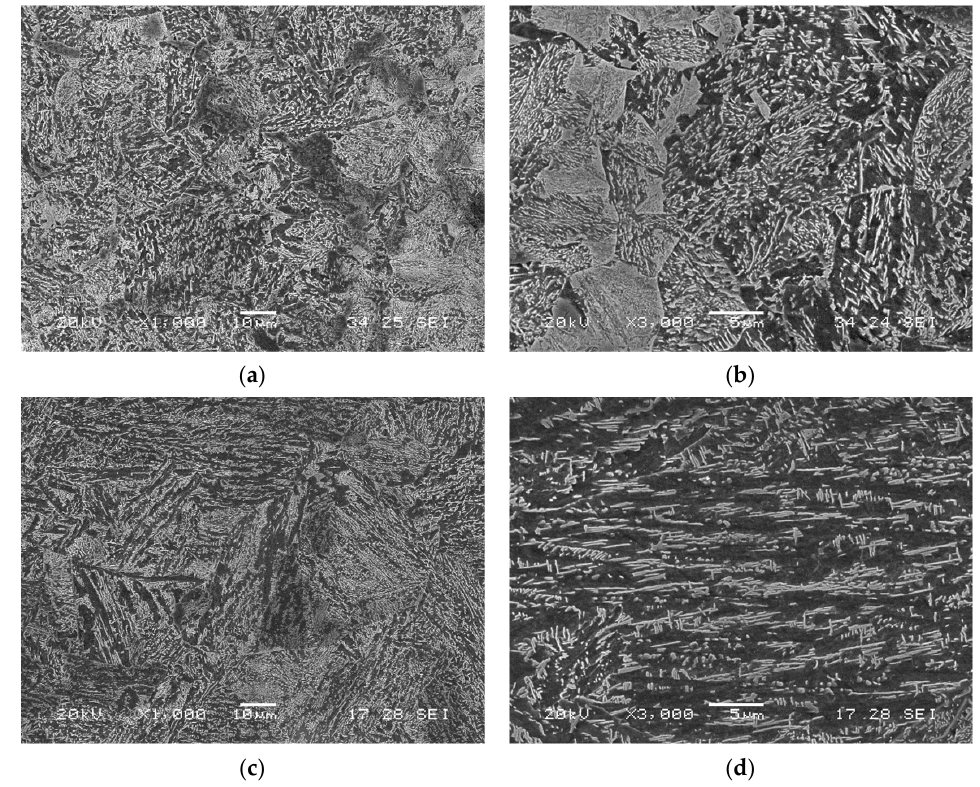
Figure 5. Microstructures (SEM) of normalized 42CrMo4 steel: AC-845, ( a ) 1000× and ( b ) 3000×; AC-